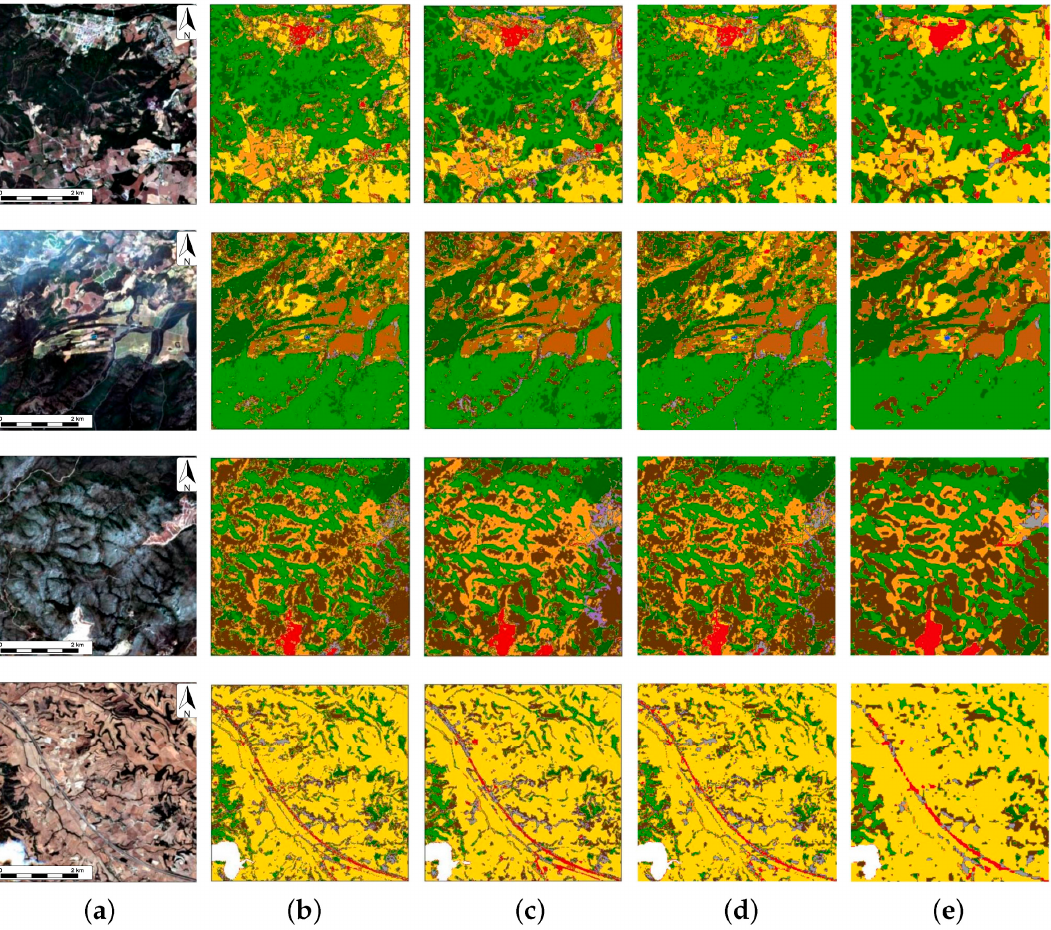
Figure 12. Comparison of segmentation results obtained with our dual approach (SSSR) and with DeepLabV3+ trained using a low-resolution dataset: ( a ) input image, ( b ) HR ground truth map, ( c ) our SSSR results, ( d ) LR ground truth map, ( e ) segmentation results on the LR image obtained with